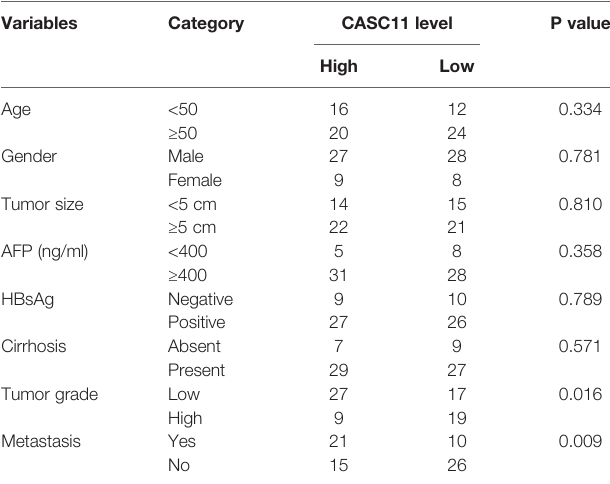
TABLE 1 | The correlation analysis between CASC11 expression and clinicopathological features of HCC patients. Variables